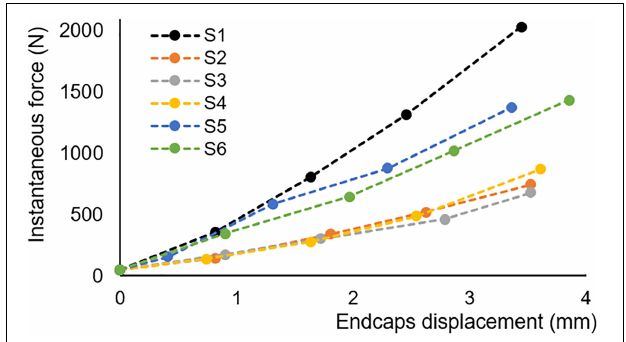
FIGURE 5 | In vitro load-displacement for all specimens, extracted from 2 spines (samples S1, S5, and S6 come from one spine; samples S2–4 come from the other spine); the load is the peak load measured, the displacement is as measured on CT scans with a resolution of 82 µ m.